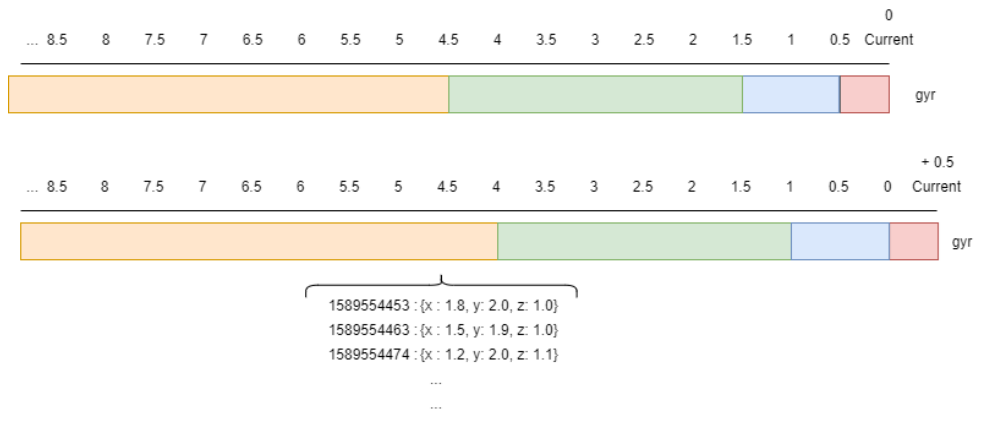
Figure 16. Raw data storage in Redis database.